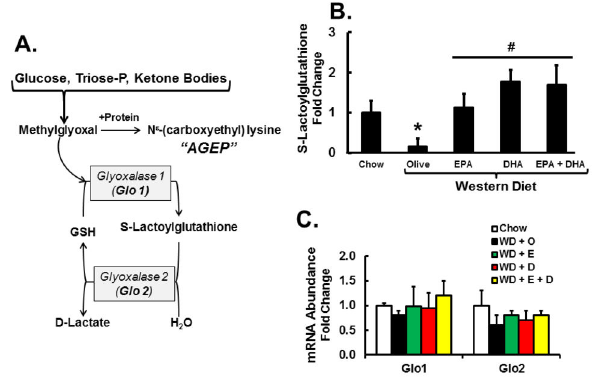
Figure 18. Diet effects on S-lactoylglutathione and metabolites from carbohydrate and lipid oxidation. Panel A: Pathway of methylglyoxal formation and detoxification. Panel B: Hepatic abundance of S-lactoylglutathione was quantified by the metabolomic analysis (Methods). Results are represented as S-Lactoylglutathione-Fold Change, relative to chow-fed mice; mean ± SD, n=8/group. Panel C: Expression of enzymes involved in S-lactoylglutathione formation and degradation, i.e., glyoxalase 1 (Glo 1) and glyoxalase 2 (Glo 2). Results are represented as mRNA Abundance-Fold Change, relative to chow-fed mice; mean + SD, n=8/group.